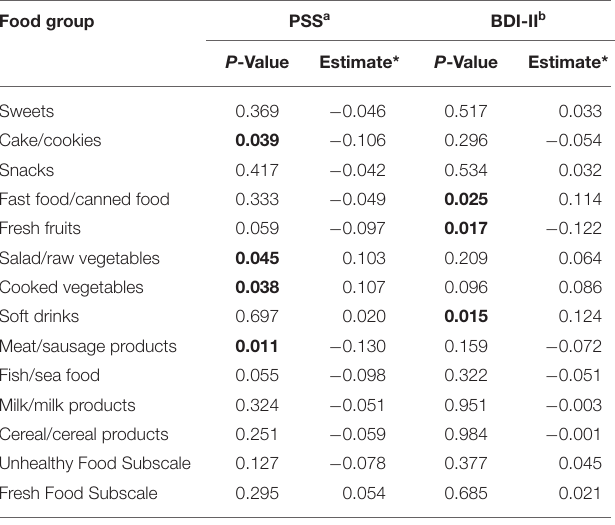
TABLE 1 | Sociodemographic characteristics and weight status ( n = 385). Characteristics